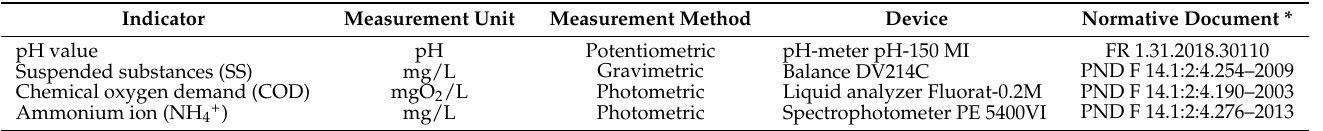
Table 2. Standard methods and